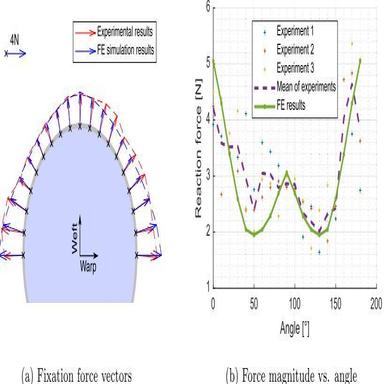
Experimental and numerical fixation forces at 60 N force: (a) force vectors at each fixation point and (b) force magnitude profile as a function of angle (0 and 180◦ corresponds to the warp direction and 90◦ to the weft direction.